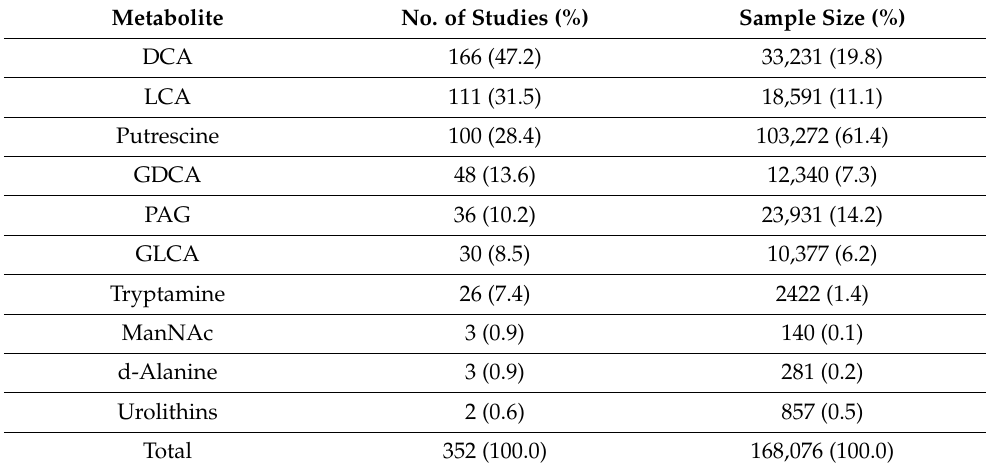
Table 1. Distribution of Metabolites.